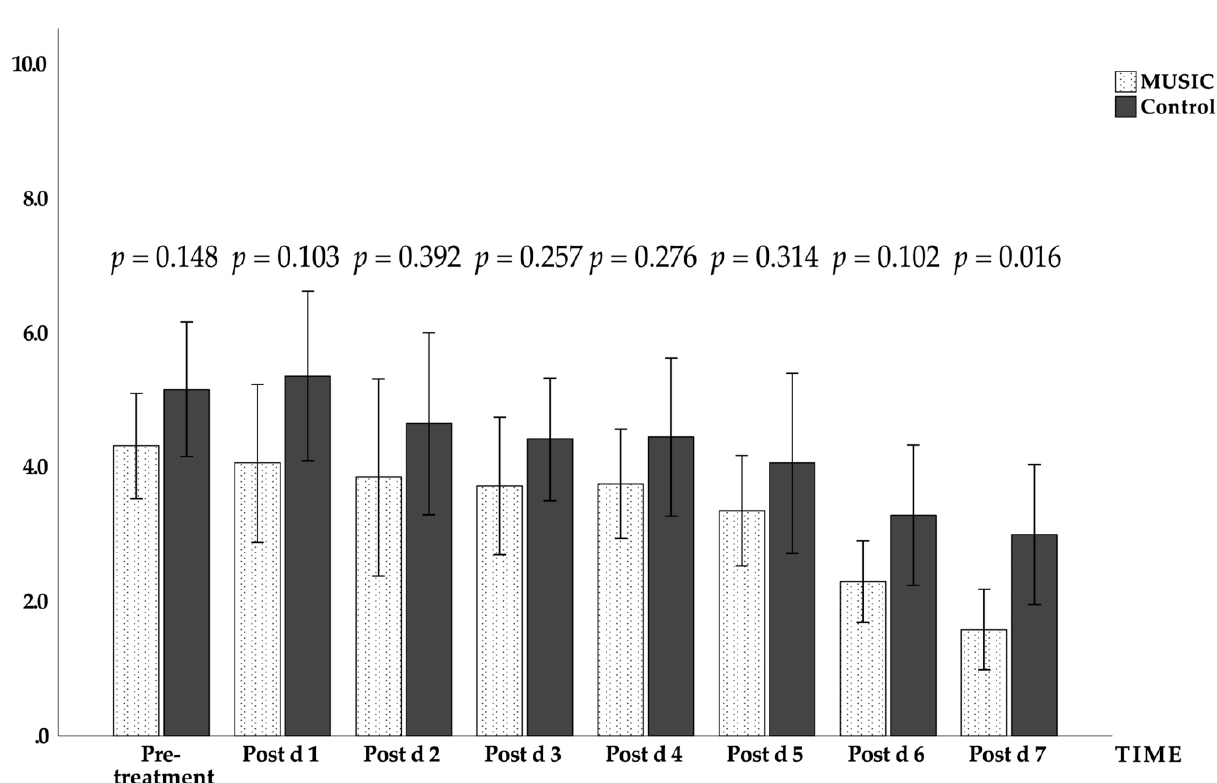
Figure 2. Daily changes in the visual analogue scale for pain in the music group and the control group during the experiment. Mean ± standard error (error bar: 95% CI). Post d, post-treatment